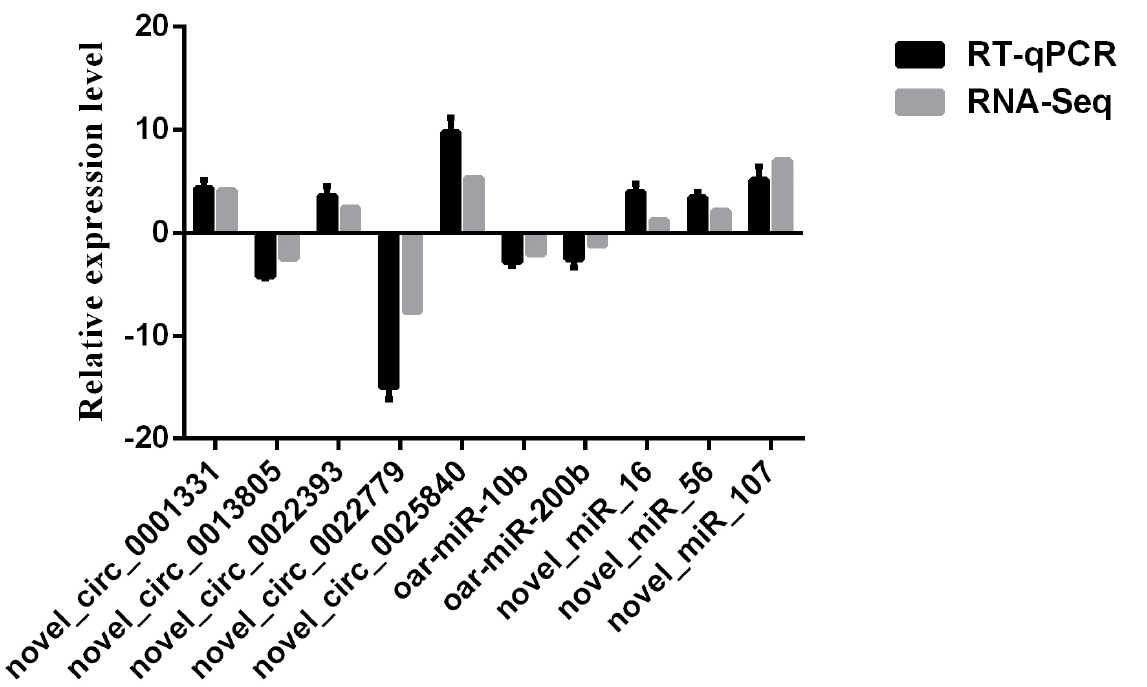
Figure 6. Comparisons of the results of the RNA–seq and RT–qPCR analyses of selected circRNAs and miRNAs.